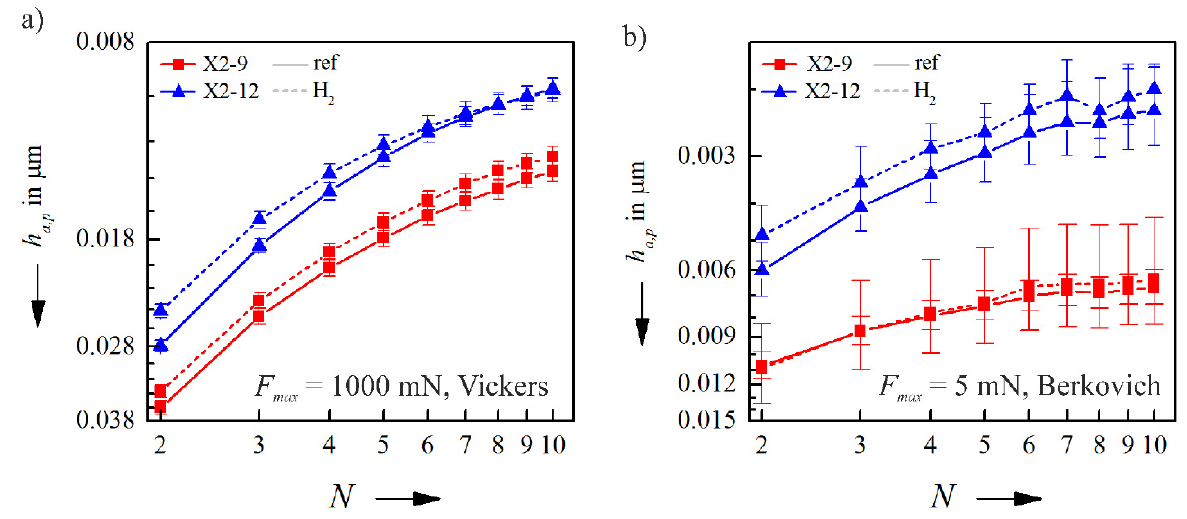
Figure 5. The ha,p - N curves of X2-9 and X2-12 metastable austenitic stainless steel samples in reference (ref) as well as hydrogen precharged (H 2 ) condition, obtained in cyclic microindentation tests with ( a ) F max = 1000 mN and a Vickers indenter, as well as ( b ) F max = 5 mN and a Berkovich indenter.